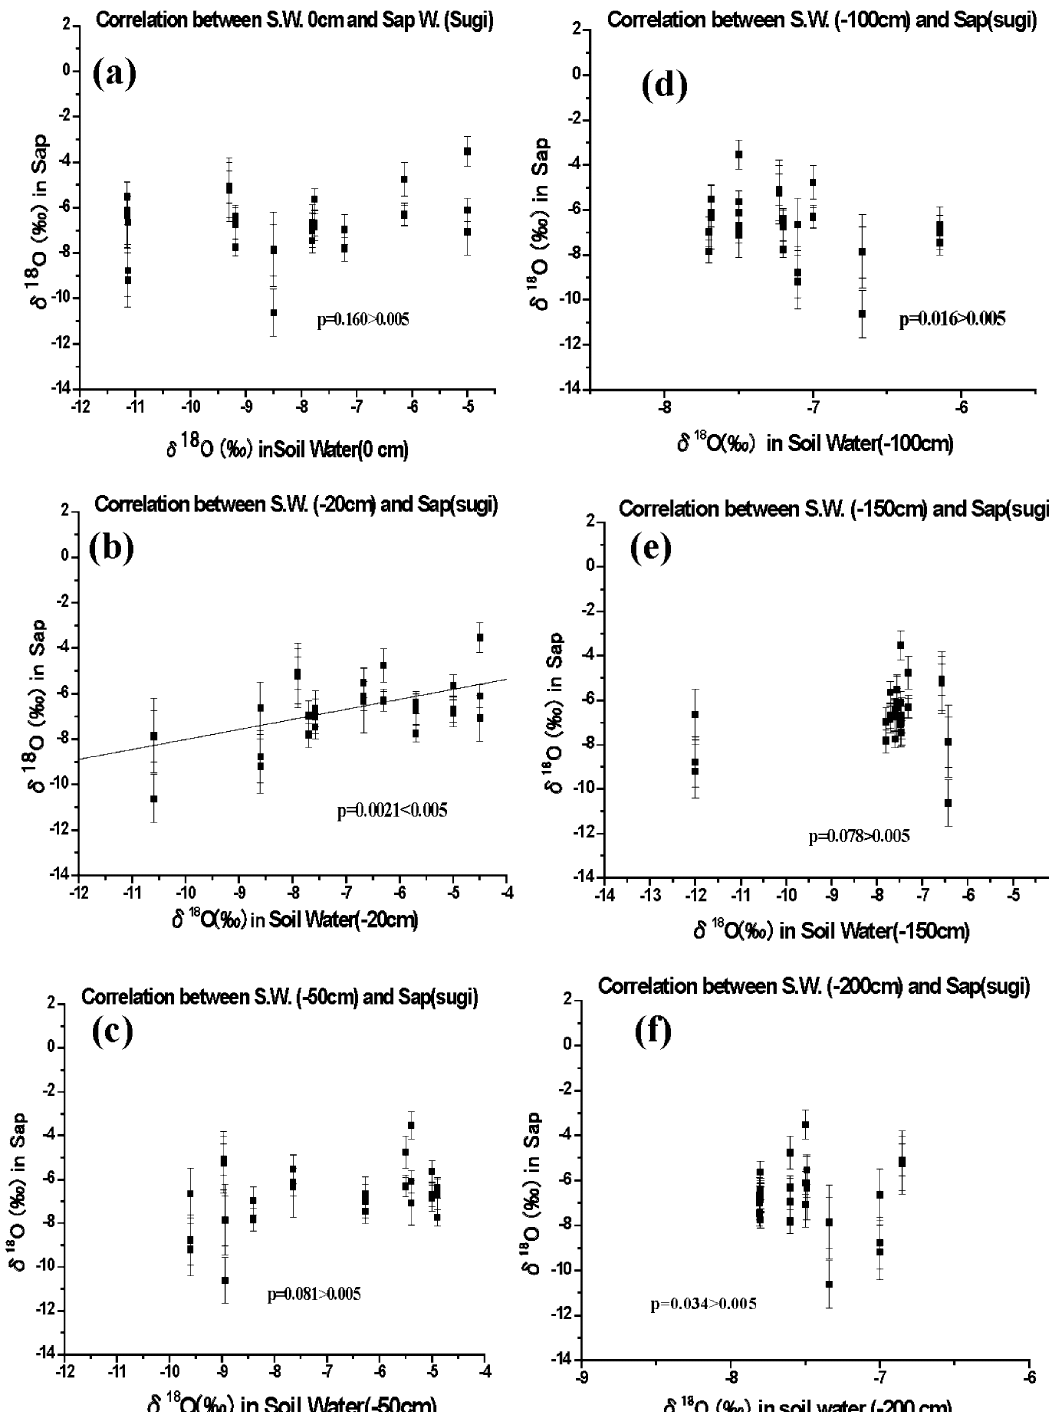
Figure 3. Relationships between soil water and sapwood sap δ 18 O values in sugi trees ( n = 3). ( a ) Rainwater collected at a depth of 0 cm and ( b – f ) soil water collected at depths of ( b ) 20 cm, ( c ) 50 cm, ( d ) 100 cm, ( e ) 150 cm, and ( f ) 200 Supplementary Tables S4 (sapwood) and S5 (heartwood) present the regression relationships between the soil water and sap δ 18 O values with the F -test in the analysis of variance. The regression goodness-of-fit values ( R 2 ) were generally weak for sapwood, with maximum values of 0.298 for sugi and 0.378 for konara at a 20-cm depth, but the F -test results showed that the slopes of the regression differed significantly from 0 ( P < 0.005). In contrast, we found no significant relationship at the other five depths except for the case of konara at a depth